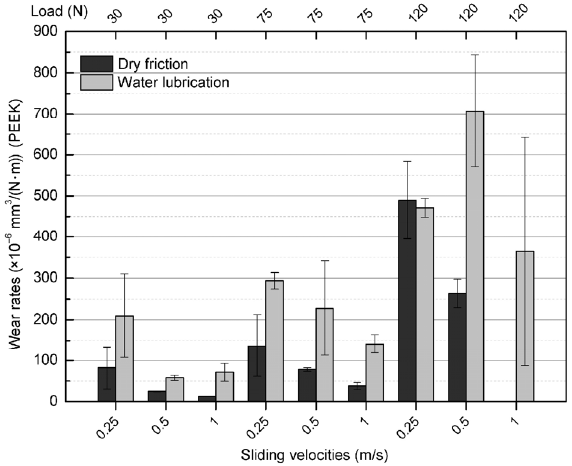
Fig. 8 The wear rates of PI at dry-friction and water-lubricated conditions under different applied loads and sliding